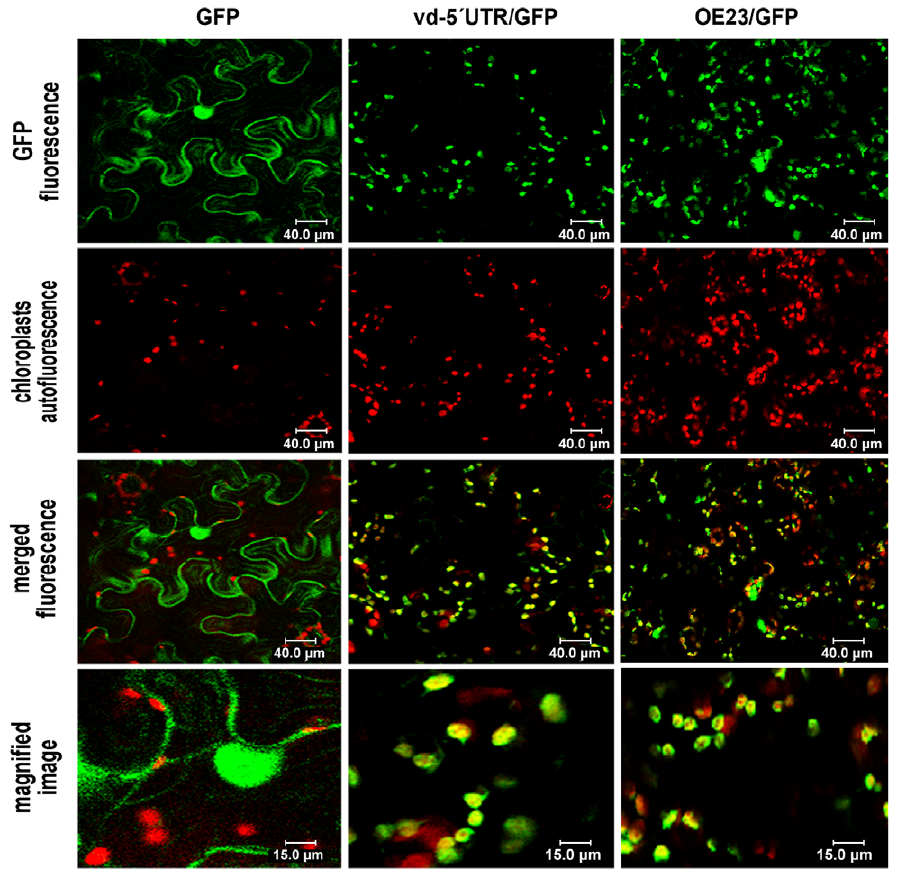
Figure 3. The GFP arising from vd-5 9 UTR/GFP transcripts accumulate specifically in chloroplasts. Confocal microscope observation of the N. benthamiana leaves expressing unmodified GFP (left panels), vd-5 9 UTR-GFP (central panels) or OE23/GFP (right panels). As observed, the vd- 5 9 UTR/GFP mimics the cellular localization of the OE23/GFP construct that accumulates specifically in chloroplasts.